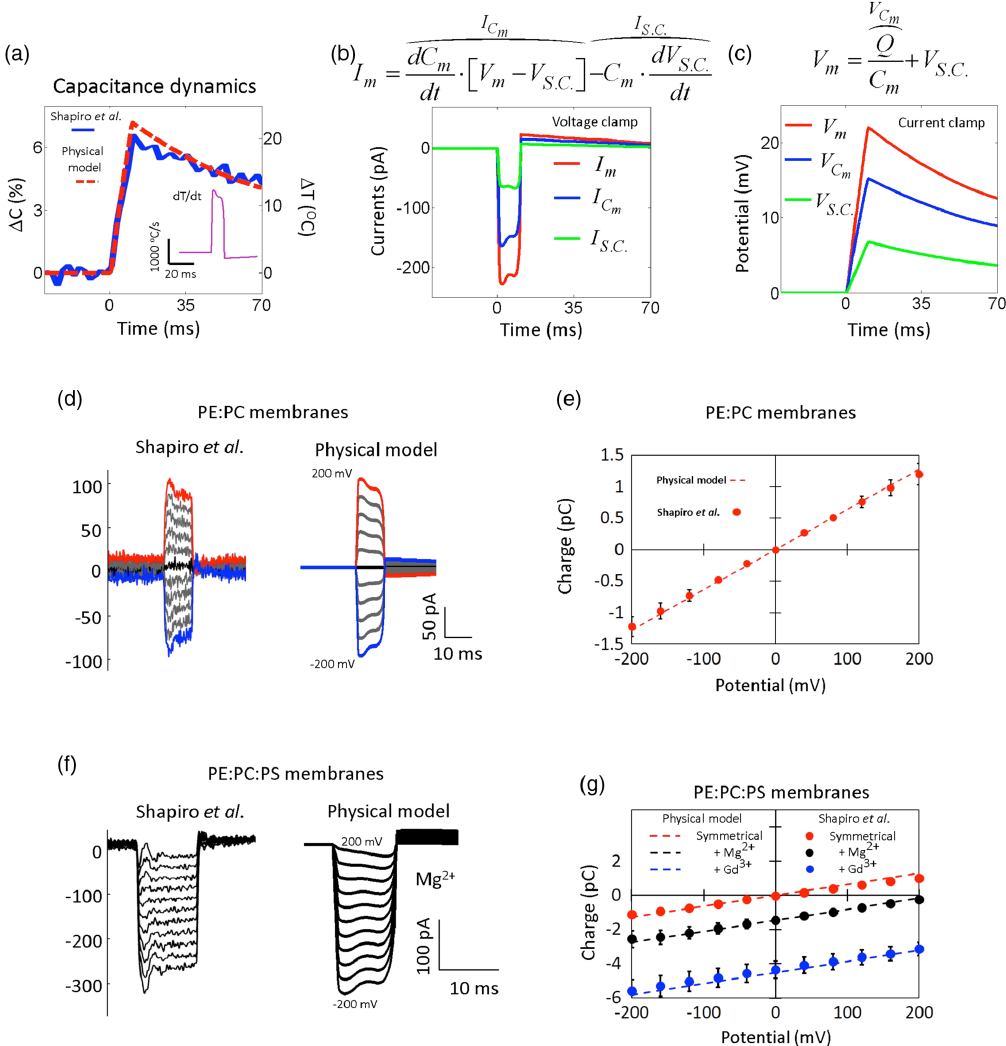
FIG. 3. Empirical results versus model-based predictions for artificial bilayer membrane INS experiments. (a) Predicted versus measured capacitance dynamics for 10 ms pulses. The capacitance change is proportional to the temperature transient (inset: temperature time derivative). (b),(c) Underlying membrane currents and potentials in response to the temperature transient in (a). The overall response is determined by the additive contribution of the membrane capacitance and surface charge-related potential thermal responses. (d) – (g) Predicted versus measured thermal membrane currents (d),(f) and induced charge (e),(g) for PE:PC membranes and for PE:PC: PS membranes. Addition of 14 mM MgCl 2 (f),(g) or 1 mM GdCl 3 (g) to the “ extracellular ” compartment shifts towards more depolarizing currents through membrane absorption of excess ions changing the extracellular surface charge density. The simulations use the experimental parameters of Shapiro et al. [16] (Table SI of Supplemental Material [40]). Error bars are (cid:1) s : e :